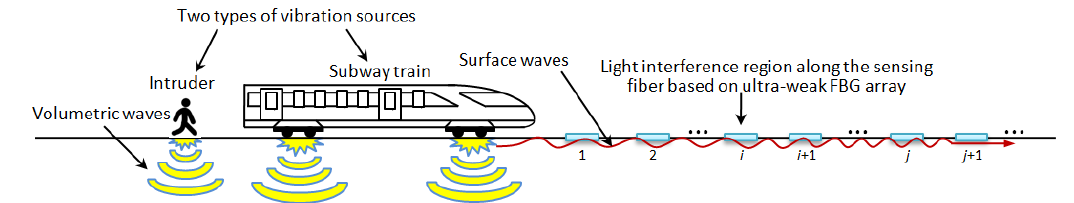
Figure 2. Monitoring principle of capturing the two types of moving loads of interest based on distributed vibration.